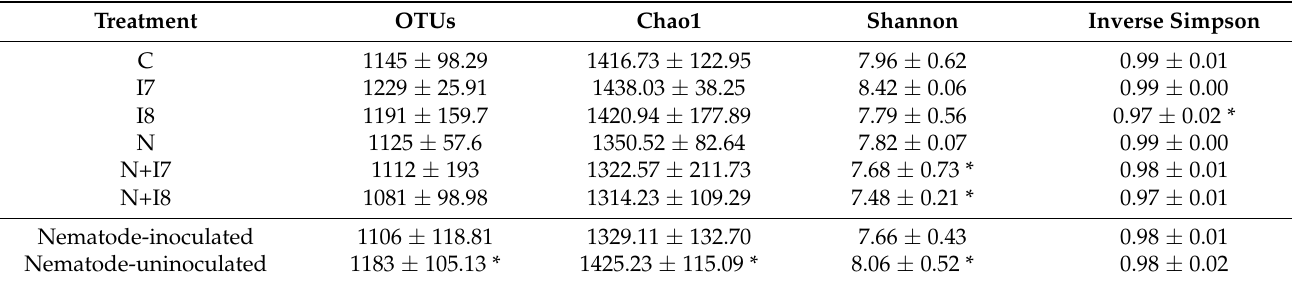
Table 1. Alpha diversity indices of rhizosphere microbiota from pine seedling